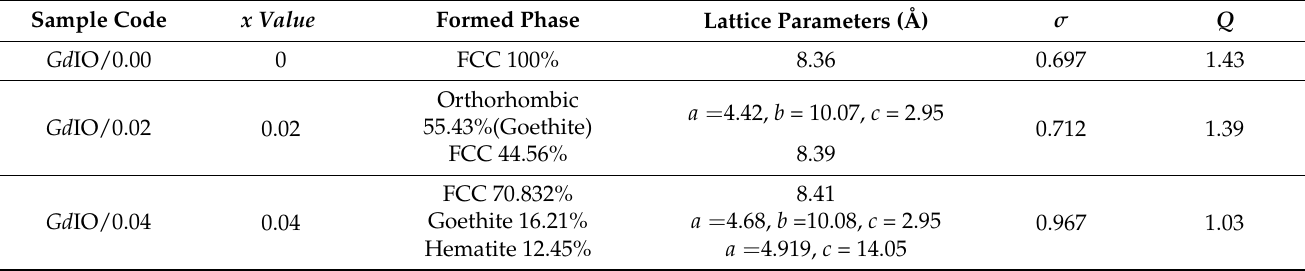
Figure 2. X-ray diffraction pattern for samples Gd IO/0, Gd IO/0.02, Gd IO/0.04, Gd IO/0.06, Gd IO/0.08 and Gd IO/0.1 arranged from top to bottom. Table 1. The obtained phases and their percentages for each sample along with the refinement parameters. Sample